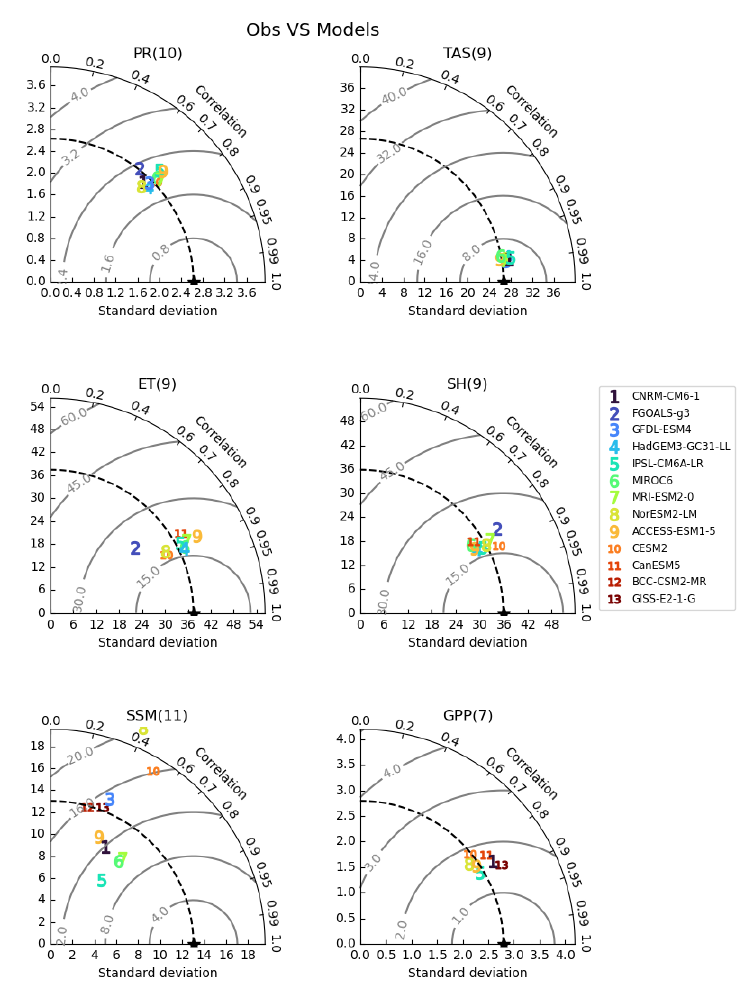
Figure 1. Taylor diagram for model validation. PR, TAS, ET, SH, and SSM data were compared with ERA5 data from 1981 to 2010, and SSM data were compared with FLUX-MTE data from 1982 to